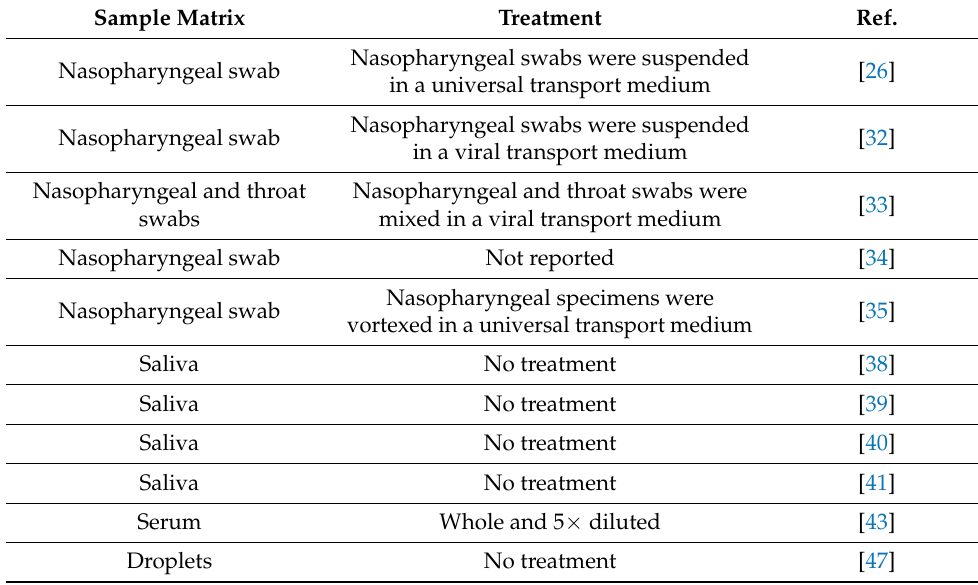
Table 2. Sample treatment of biosensors in the